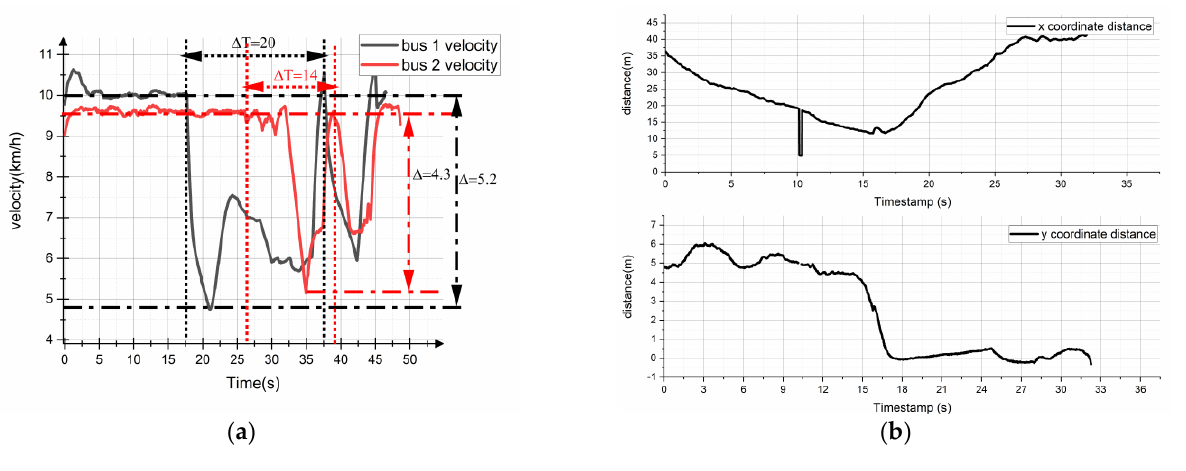
Figure 23. Speed and relative distance of real vehicle test 3: ( a ) queue vehicle speed without flexible following factor or flexible fading factor; ( b ) queue vehicle transverse–longitudinal trajectory without flexible following factor or flexible decay factor.